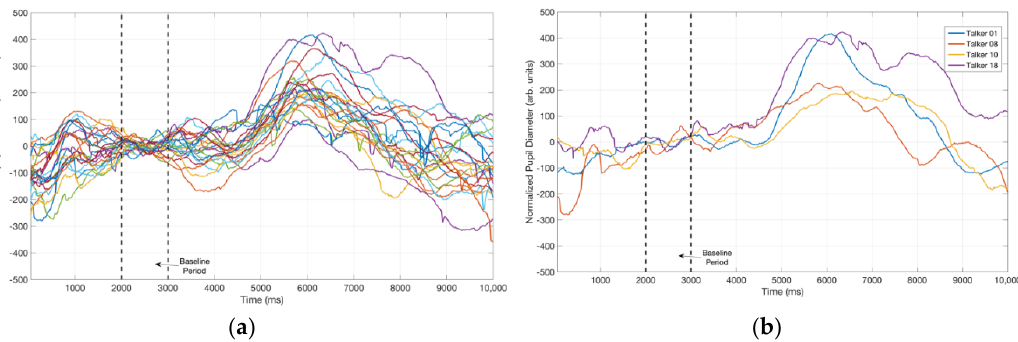
Figure 4. ( a ) Baseline-normalized and averaged pupil tracks associated with all 23 adductor spasmodic dysphonia (AdSD) talker samples. ( b ) Baseline-normalized and averaged pupil tracks associated with the two highest (1 and 18) and two lowest (8 and 10) rated talkers on the vocal dimension of strain. The difference in peak pupil dilation (PPD) between the highest and lowest rated talkers is noteworthy in this plot.